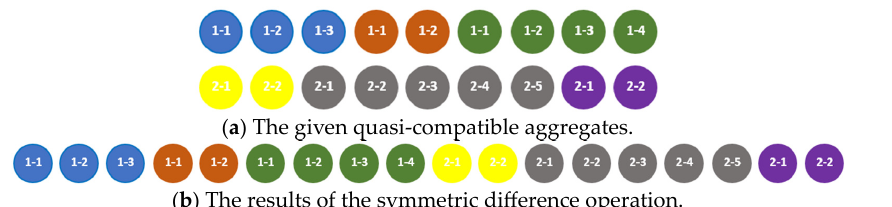
Figure 14. An example of applying the symmetric di ff erence operation to two quasi-compatible ag- gregates.